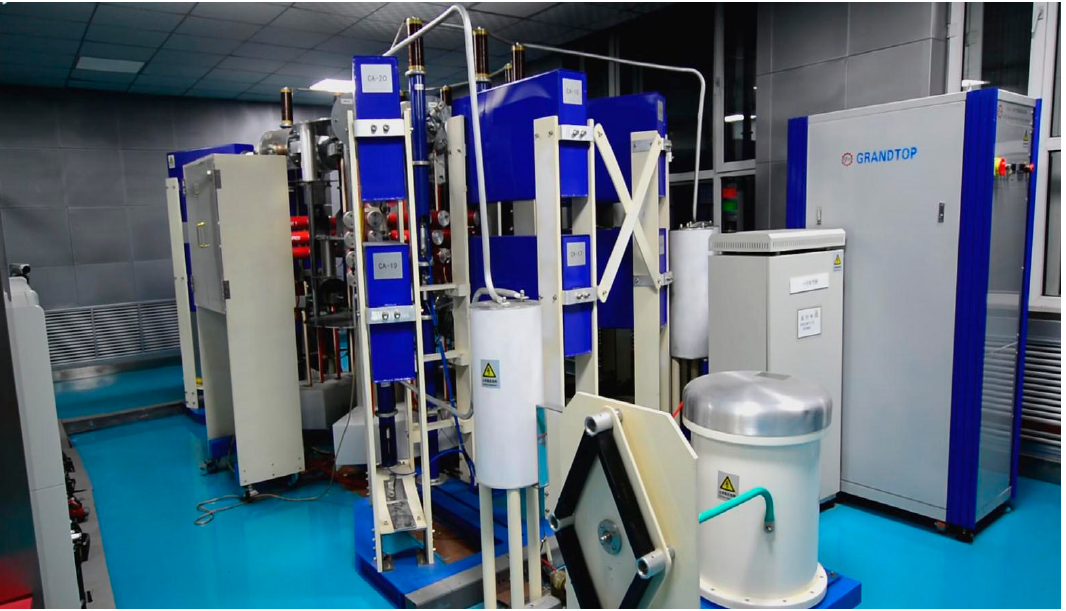
Figure 1. 20-pulse lightning impulse current generator.